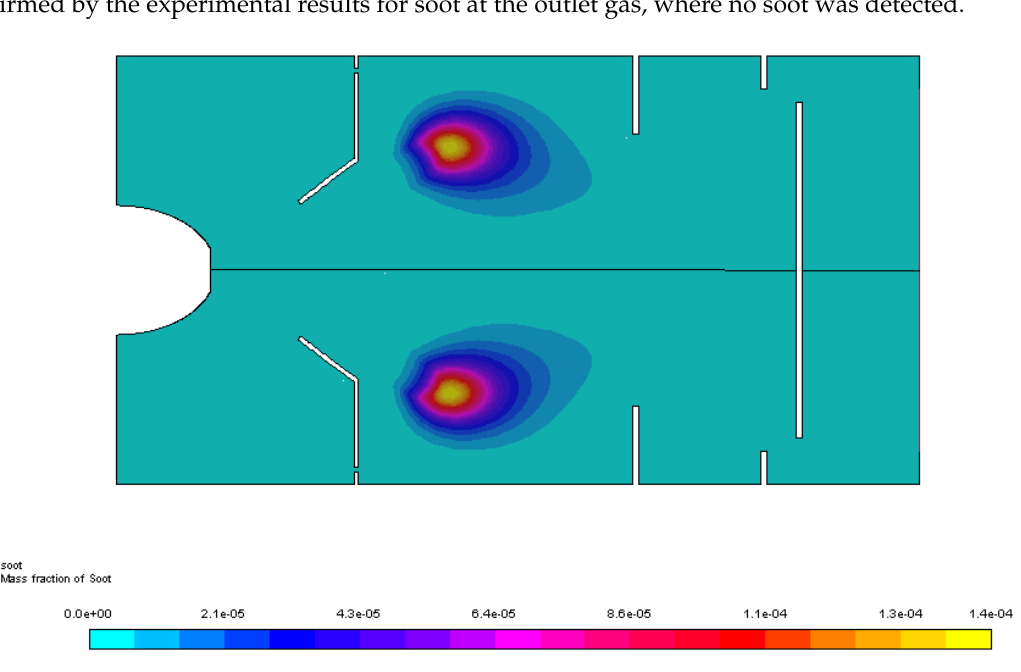
Figure 7. Tracking soot formation and profiles of soot mass fraction in the combustion zone, geometry C.